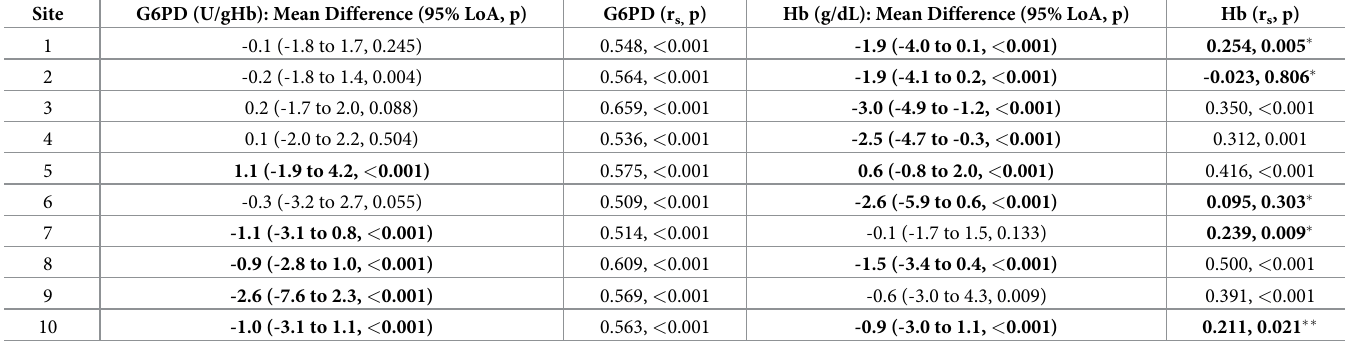
Table 3. Mean difference and correlation of Biosensor and reference method by site in phase B. Site G6PD (U/gHb): Mean Difference (95% LoA,